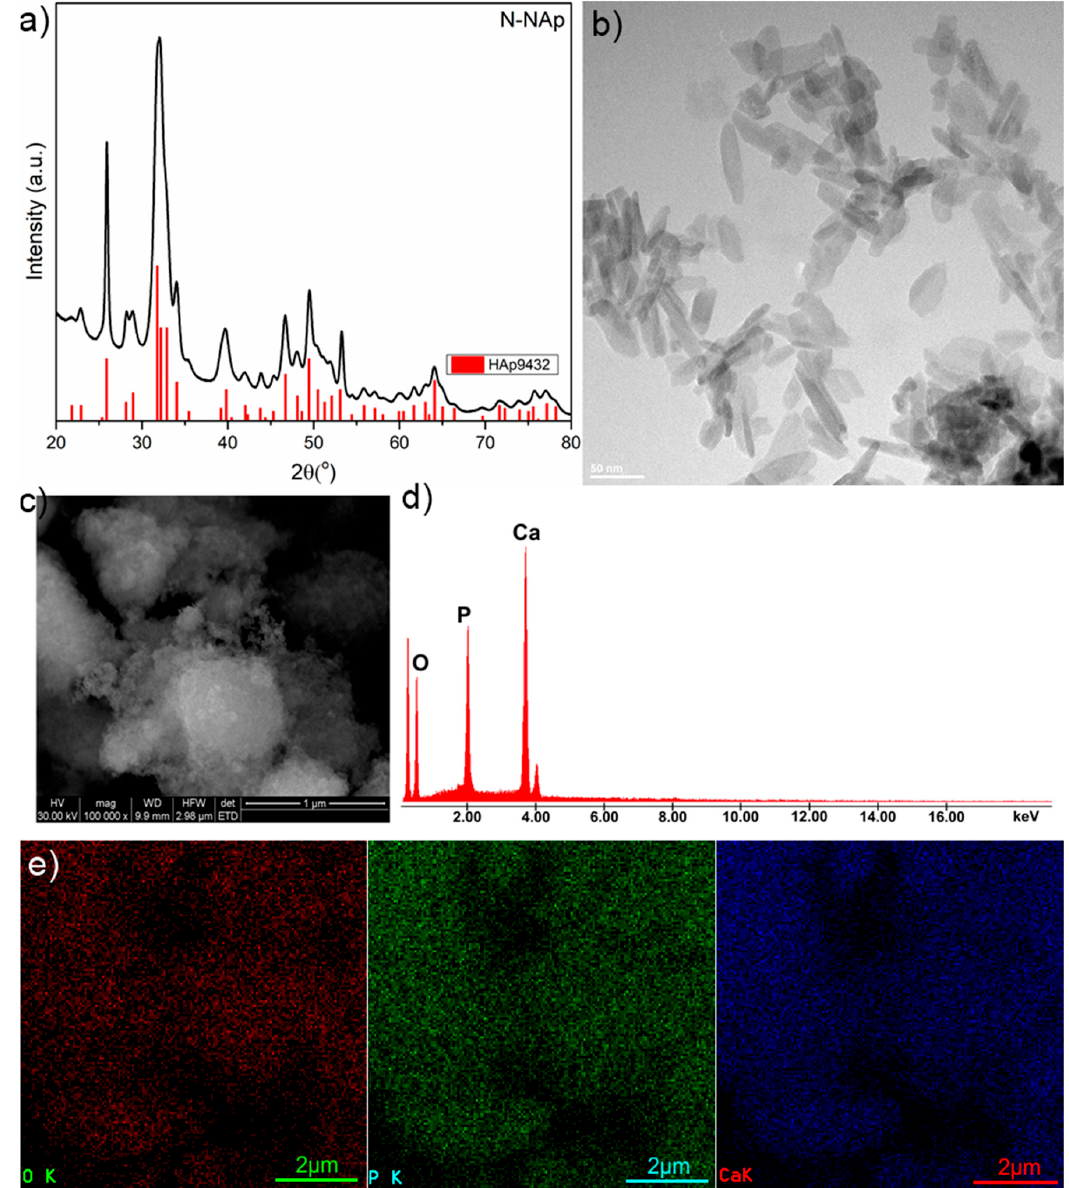
Figure 1. XRD patterns of hydroxyapatite nanopowders (N-HAp) nanopowders and ICDD-PDF (International Center for Diffraction Data- Powder Diffraction File) 9-432 ( a ); TEM image of N-HAp nanopowders ( b ); SEM micrograph of N-HAp ( c ); EDX spectra of N-HAp nanopowders ( d ); elemental mapping of N-HAp nanopowders ( e ).